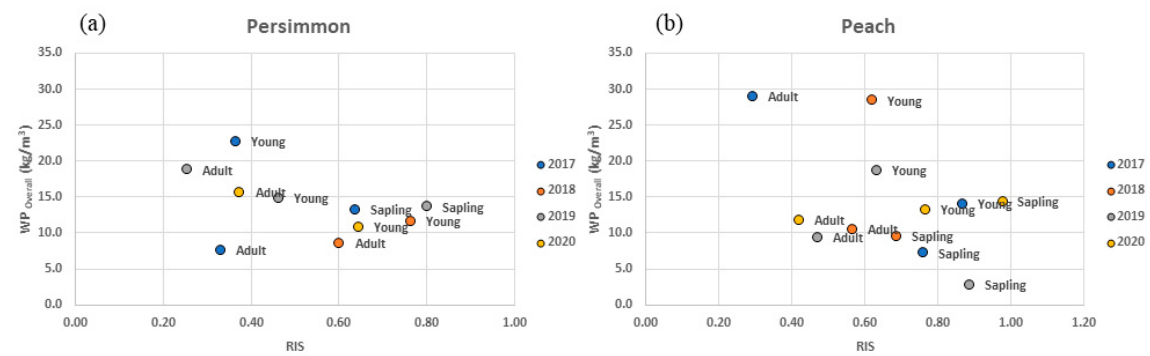
Figure 4. WP overall vs. RIS.: ( a ) persimmon; ( b ) peach. Each dot corresponds to a tree size for years 2017 to 2020.